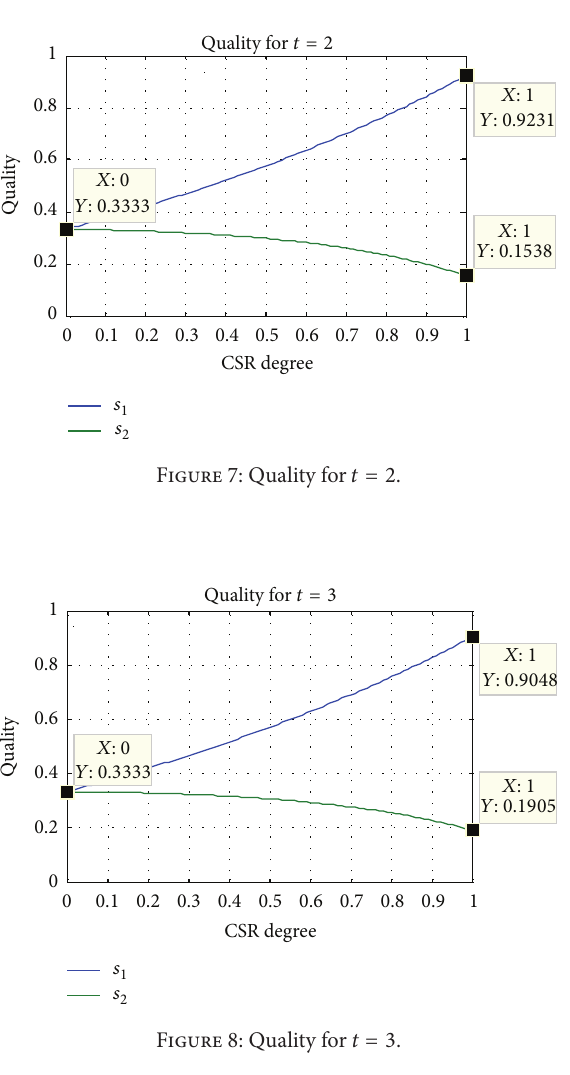
Figure 8: Quality for 𝑡 = 3